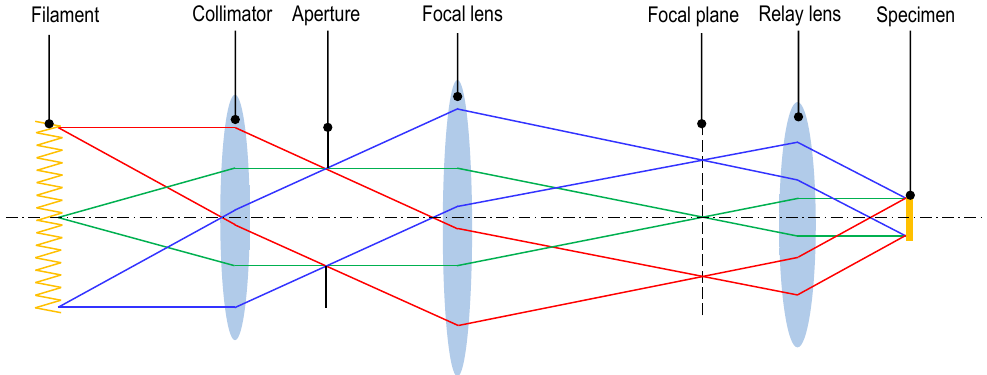
Figure 2. Typical Köhler illumination principle in microscopy systems,it provides a homogeneous illumination pattern for the specimen by imaging the